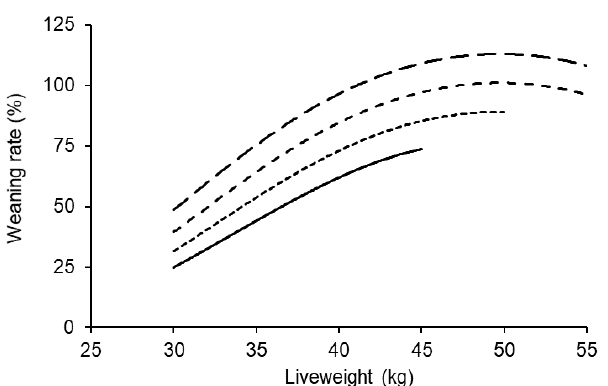
Figure 1. The effect of liveweight at the start of breeding on weaning rate for ewe lambs that were 6 (bottom), 7, 8 or 9 (top) months of age. The data represent over 11,500 maternal composite ewe lambs and the average across the ewe lambs ’ own birth type. The average 95% confidence interval across all scenarios was ±6.6%.